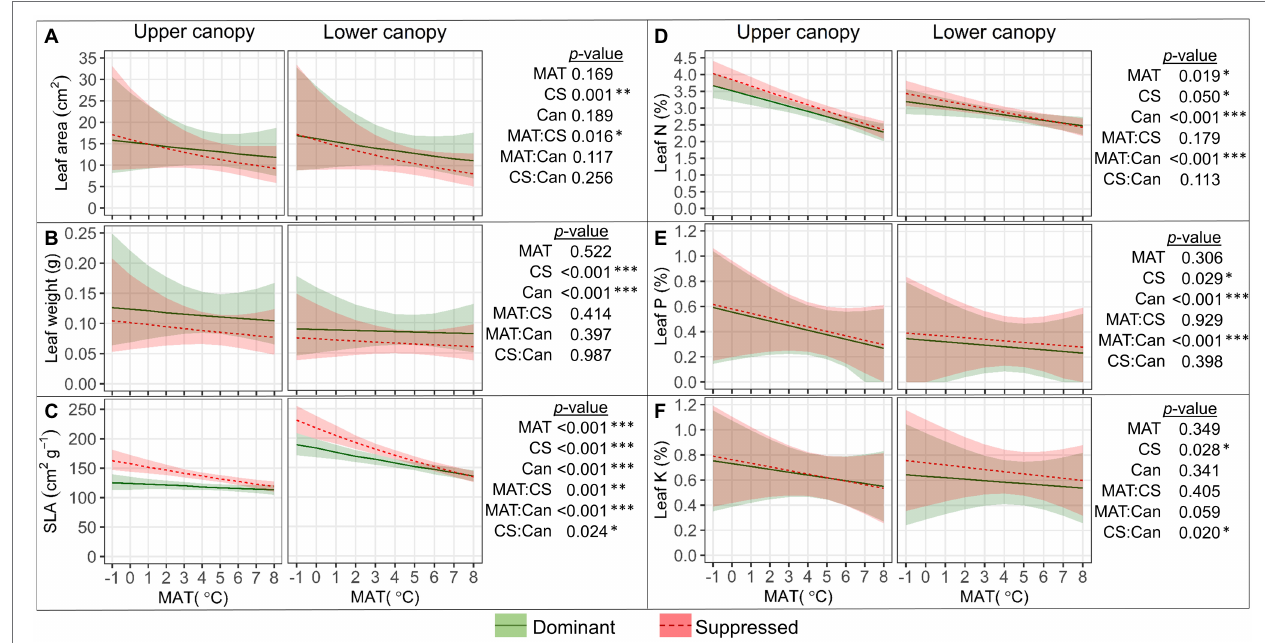
FIGURE 5 | Relationships between leaf size characteristics (SLA, specific leaf area; A–C ), leaf macronutrient content (D–F) , and mean annual temperature (MAT) in upper and lower canopy of competitively dominant and suppressed silver birches (predicted mean trend with 95% confidence bands based on LMM). Curvilinear trendlines indicate that data were log -transformed prior to LMM analysis and the model predictions were back-transformed for data visualization. The significance of the factors (MAT; CS, competitive status; Can, canopy position) is shown next to the graphs: * p < 0.05, ** p < 0.01, *** p < 0.001.